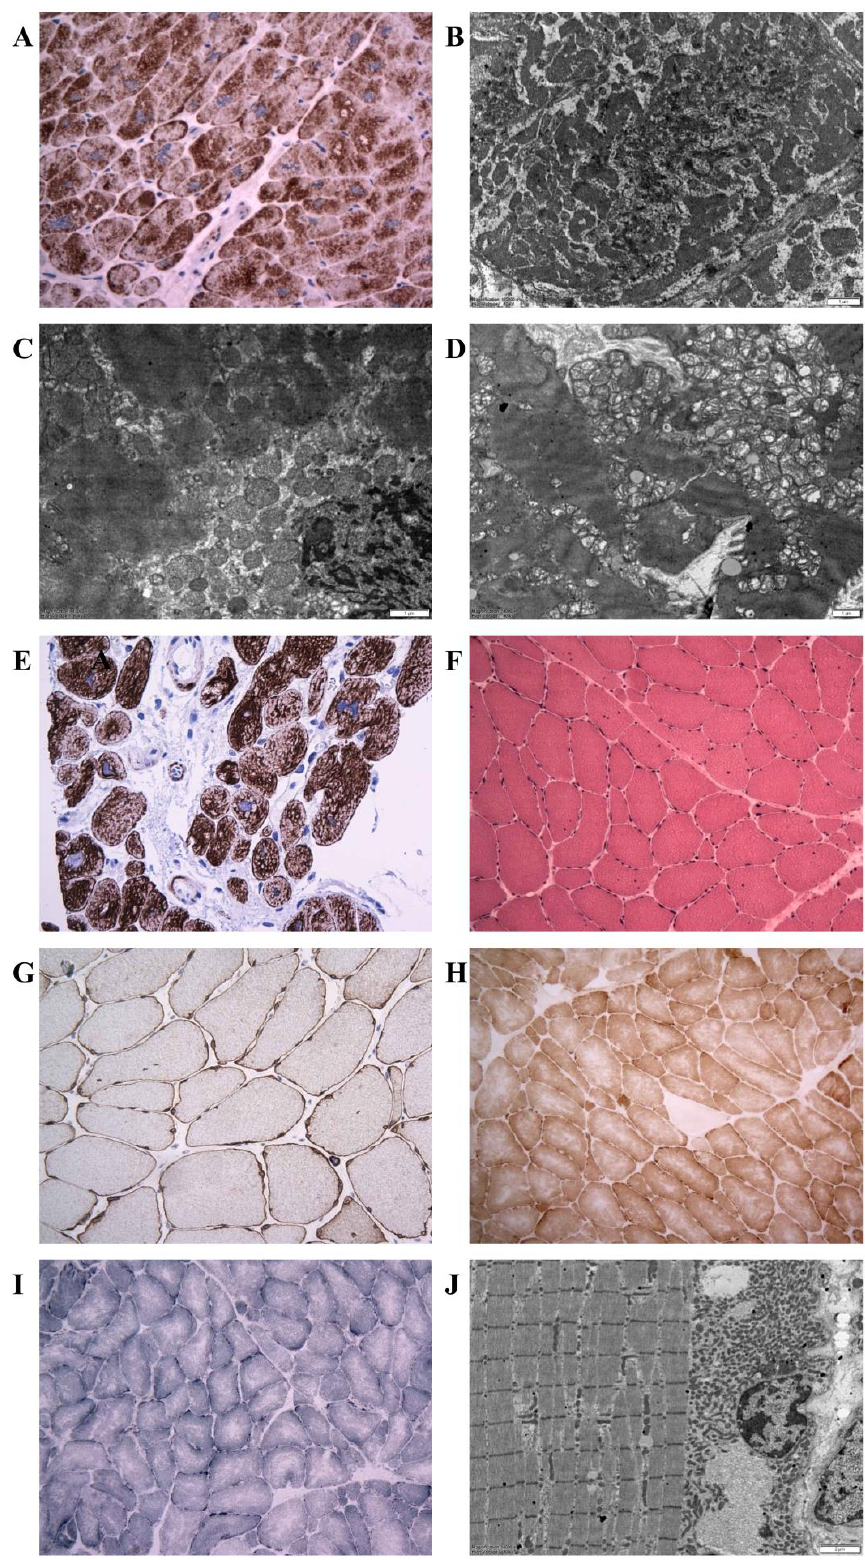
Figure 4. Illustration of histopathology, immunohistochemistry, and electron microscopy in individuals with the novel desmin variants. ( A ): Desmin immunohistochemistry (left ventricular myocardium, explanted heart, P1) documenting a diffuse alteration of desmin distribution with a formation of desmin aggregates revealing strong immunoreactivity in the cytoplasm. Original magnification × 400. ( B ):